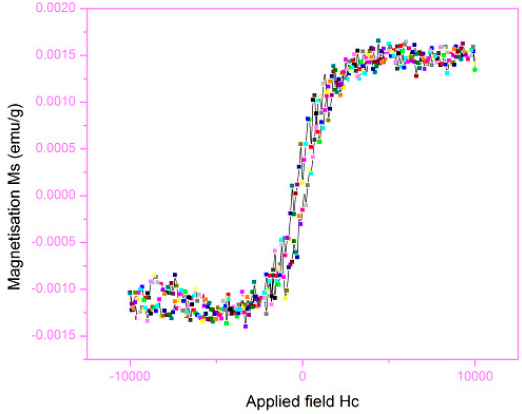
Figure 5. Room-temperature magnetic hysteresis loops of nickel oxide.